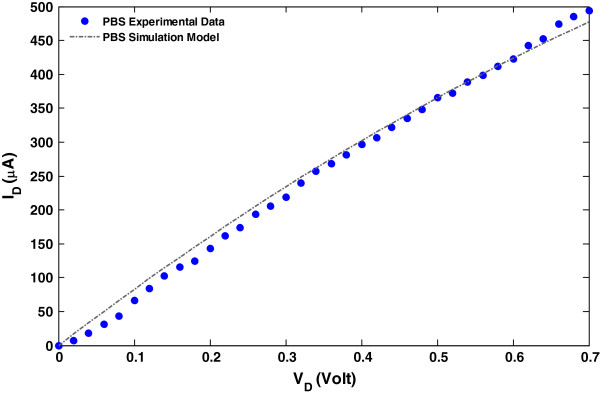
Comparison of the I-V simulation output and the experimental data [[24]]. PBS concentration FPBS = 1 mg/mL, VGS(without PBS) = 1.5, and VPBS = 0.6 V.